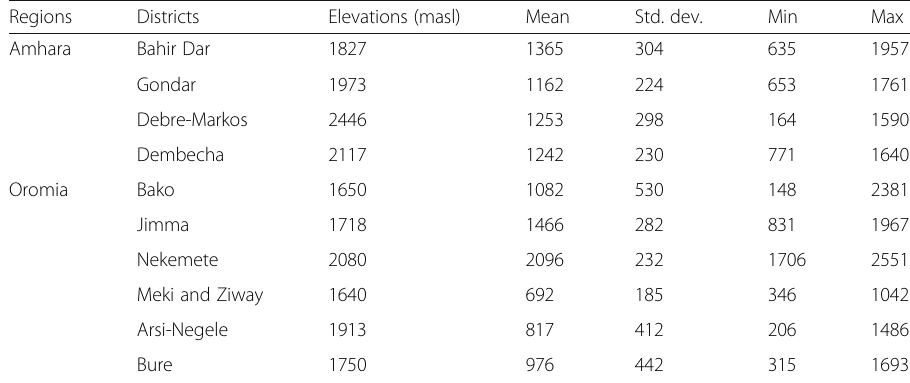
Table 2 Annual rainfall (mm) for major maize producing districts (1995 – 2014) Regions